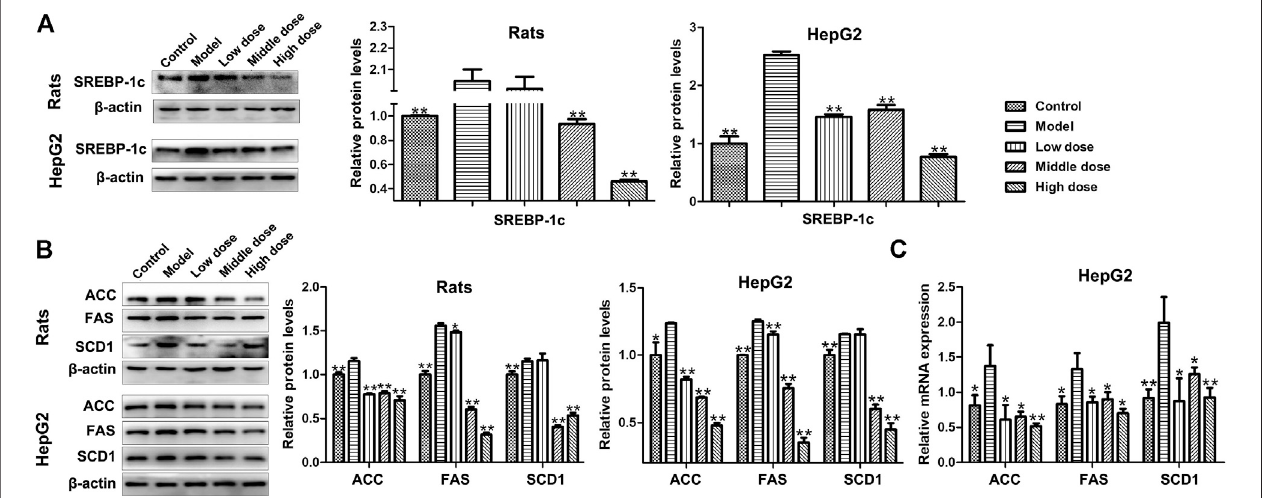
FIGURE7| EffectofHSAVontheexpressionsofdownstreamproteinsrelatedtoPGC-1 β mediatedlipidmetabolismpathway. (A) TheexpressionlevelofSREBP- 1c by Western blot; (B) the expression levels of ACC, FAS, and SCD1 by Western blot; (C) the mRNA levels of ACC, FAS, and SCD1 in HepG2 cells by Real-time PCR. Data are presented as the mean ± SD (n (cid:2) 3). * p < 0.05 and ** p < 0.01 compared with model group.